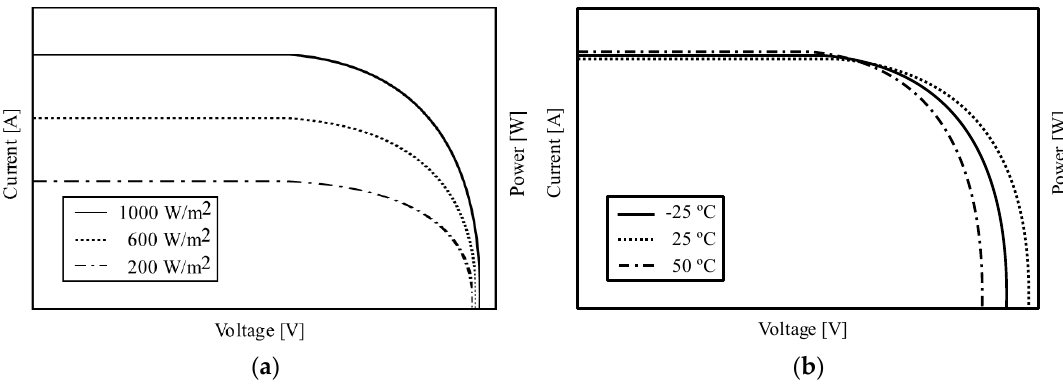
Figure 3. The I–V curves of a PV module at different levels of solar radiation. Source [11] , own elaboration: ( a ) Irradiation dependence; ( b ) Temperature dependence.